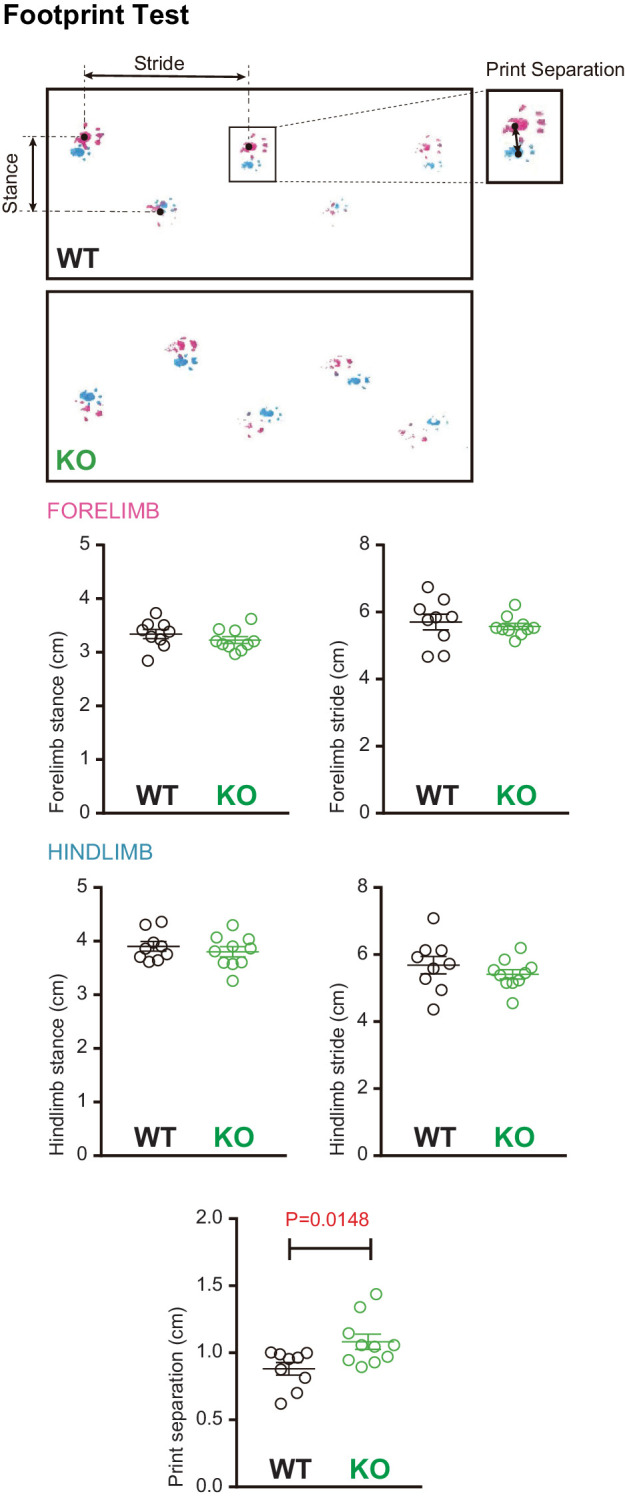
Footprint analysis in Susd4 knockout (KO) mice.Footprint patterns of P30 Susd4WT and Susd4 KO mice were quantitatively analyzed by measuring stride length for the fore paws (magenta) and hind paws (cyan), stance length for the forelimbs and hindlimbs, and print separation. Mean ± s.e.m. (WT n = 9 and KO n = 10 mice; unpaired Student’s t-test; forelimb stance: p=0.3059; forelimb stride: p=0.5882; hindlimb stance: p=0.4533; hindlimb stride: p=0.3580; print separation: *p=0.0148).